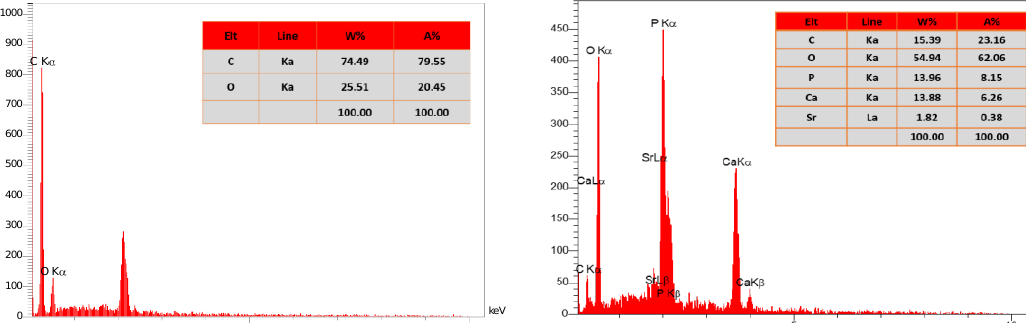
Figure (3) : EDX spectrum of PEKK and PEKK coating with SR HA specimen